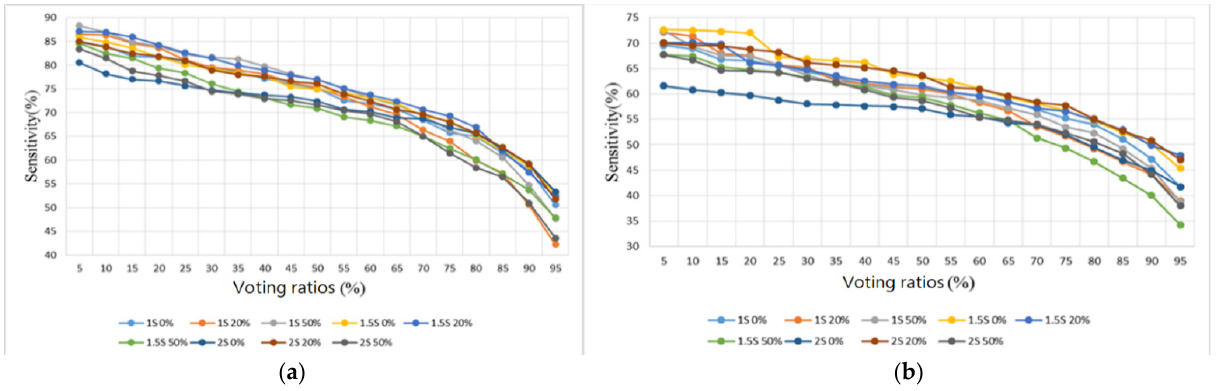
Figure 17. Heart sound classification results: Sensitivity. ( a ) Testing samples. ( b ) Noisy samples.